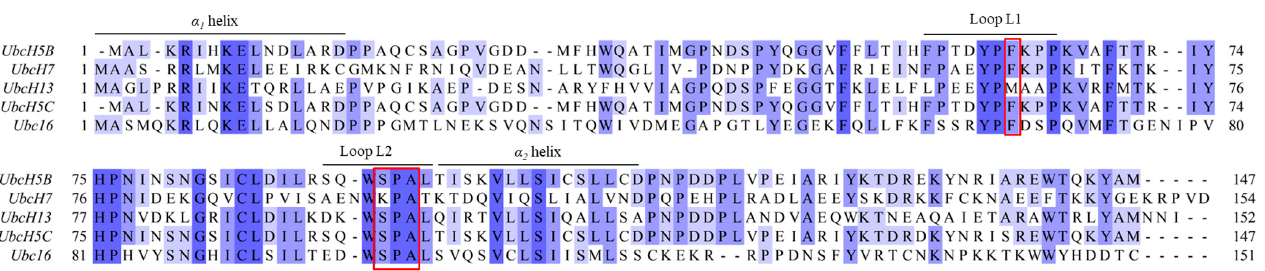
Figure 1. Sequence alignment of the UBC domain of different E2 enzymes produced by Jalview. Residues are colored according to the percentage of the residues in each column that agree with the sequence of UbcH5B (>80% dark blue, >60% medium dark blue, >40% light blue, ≤ 40% no color). The conserved phenylalanine and SPA motif at the L1 and L2 loops, respectively, are highlighted with red boxes.